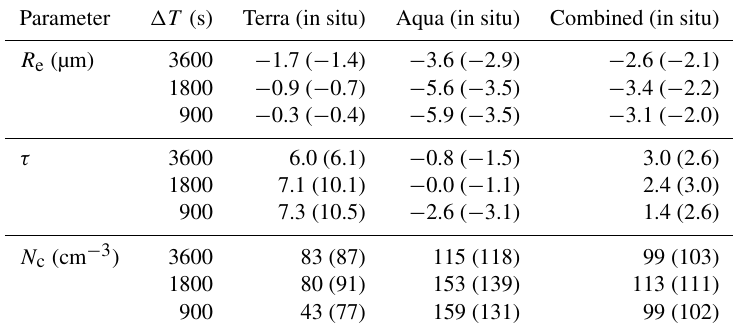
Table 4. Differences between the average R e , τ , and N c for contact and separated profiles based on MODIS retrievals (Terra, Aqua, and combined) and in situ measurements. Positive values indicate contact profiles had a higher value.